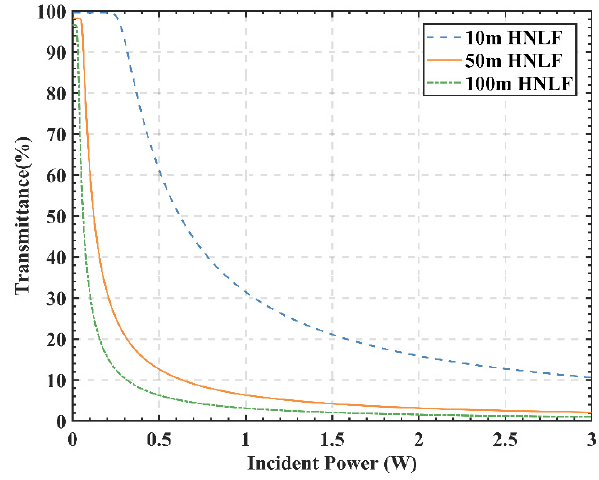
Figure 2. Numerical results of transmittances for HNLF at three different lengths.